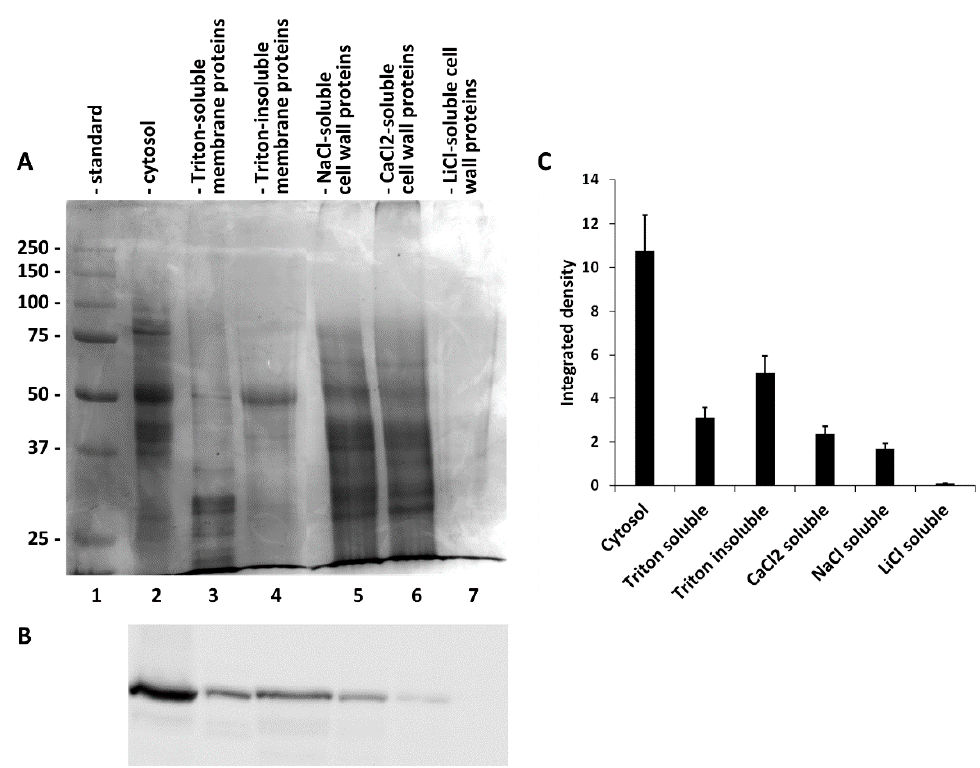
Figure 4. ( A ) Gel electrophoresis assessment of protein fractions obtained using differential extraction from nettle stems. Lane 1, molecular weight standard, whose value in kD is shown on the left; lane 2, cytosol proteins; lane 3, Triton-soluble membrane proteins; lane 4, Triton-insoluble membrane proteins; lane 5, cell wall proteins extracted with NaCl; lane 6, cell wall proteins extracted with CaCl 2 ; 7, cell wall proteins extracted with LiCl. All lanes except for number 7 contained the same amount of protein. ( B ) Western blot analysis of the same fractions presented in A with the antibody against Arabidopsis -1. ( C ) Quantization of western blot presented in ( B ) using ImageJ software. The intensity values of the bands are reported as the integrated density on the Y-axis.